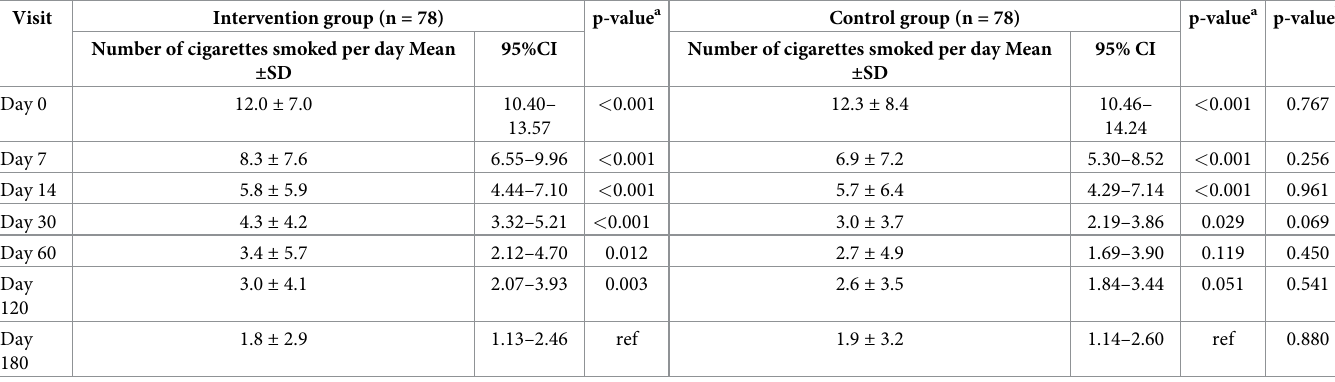
a Within group comparison using mixed models (linear: Heterogeneous First-Order Autoregressive). Day 180 was a reference. b between groups comparison using linear regression.